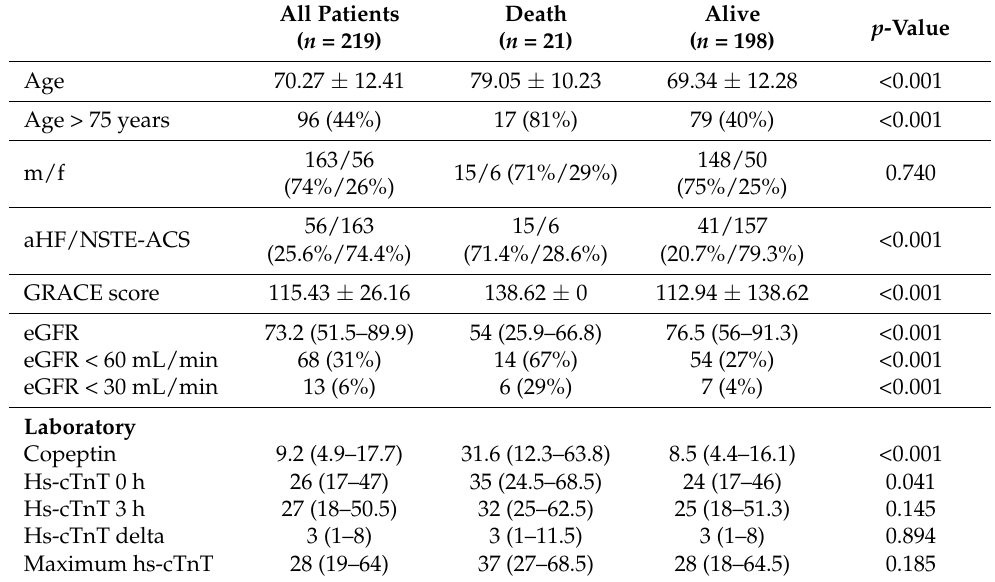
Figure 2. ( A ) ROC comparison of discriminatory ability of copeptin, hs-cTnT at 0 h and hs-cTnT at 3 h in the derivation cohort. ( B ) ROC comparison of discriminatory ability of hs-cTnT as maximal concentration and concentration change between value at presentation and value after 3 h in the derivation cohort. Table 2. Median serum concentration with respect to 99th percentile cut-o ff value. Table 3. Baseline characteristics and laboratory values by survival